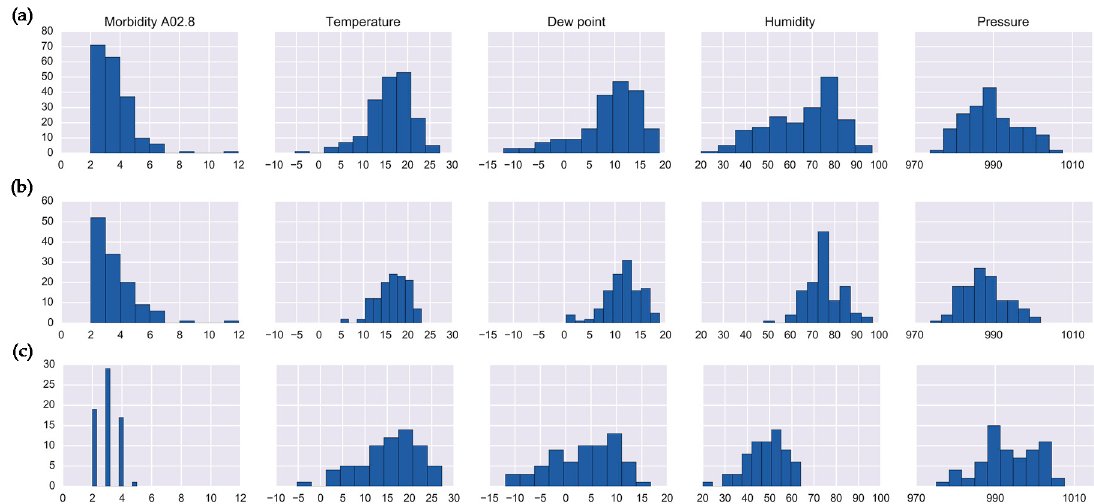
Figure 5. Histograms of salmonellosis daily counts and meteorological characteristics for: ( a ) cluster 5 (Set 1), ( b ) cluster 4 (Set 2), and ( c ) cluster 10 (Set 2). Table 3. Clustering density and homogeneity for selected clusters with high salmonellosis